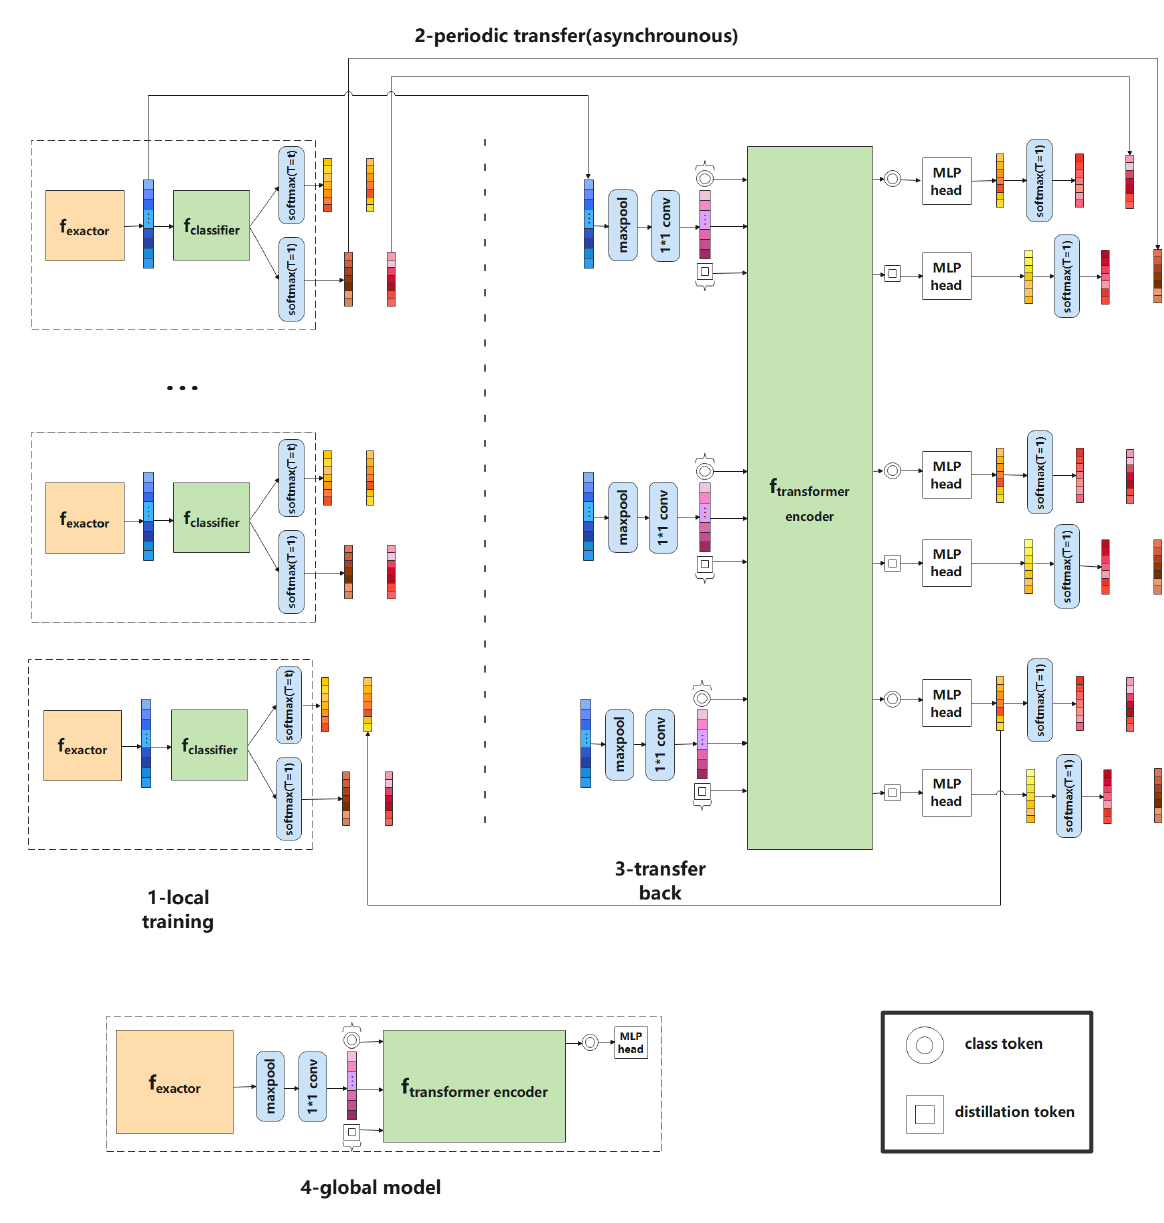
Figure 1. Training process of the FedVKD